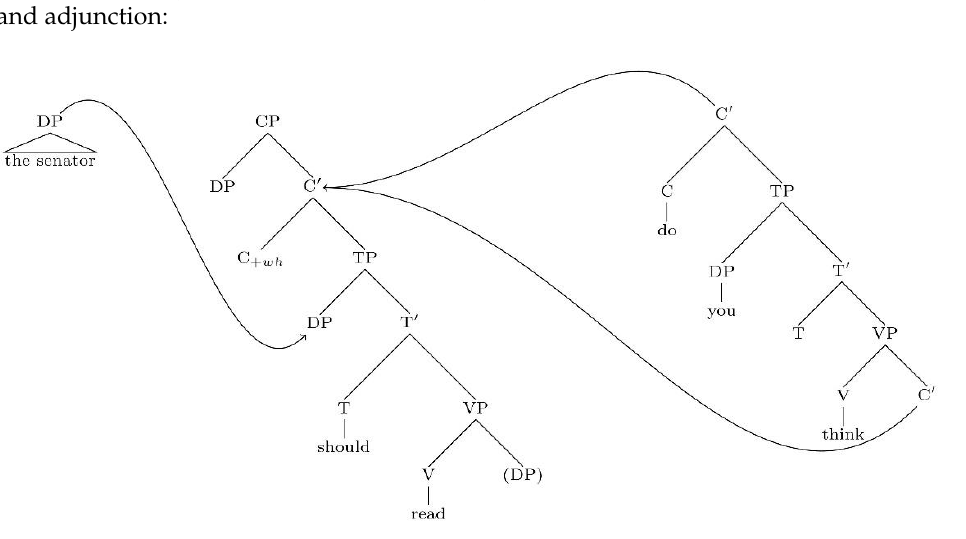
Figure 18. Derivation with Substitution and Adjunction